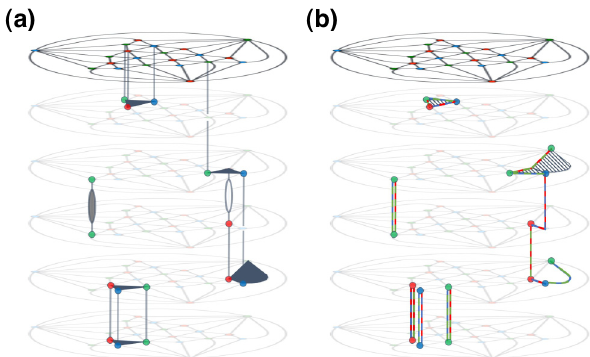
FIG. 11. The noisy-syndrome projection decoder on the (2+1)D color-code lattice (cid:14) . (a) During each QEC cycle, errors can appear on data qubits (shaded triangles), followed by stabi- lizer measurements, which when incorrect are drawn as